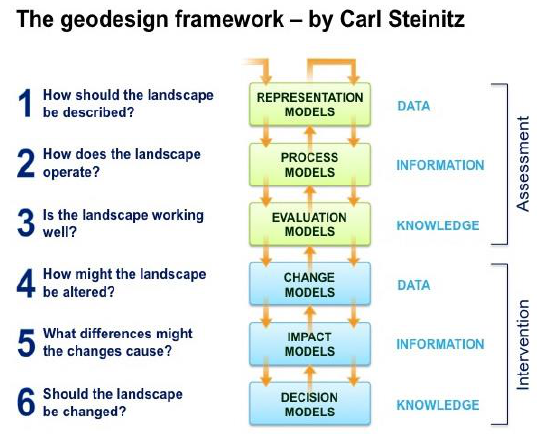
Figure 3. Geodesign framework by